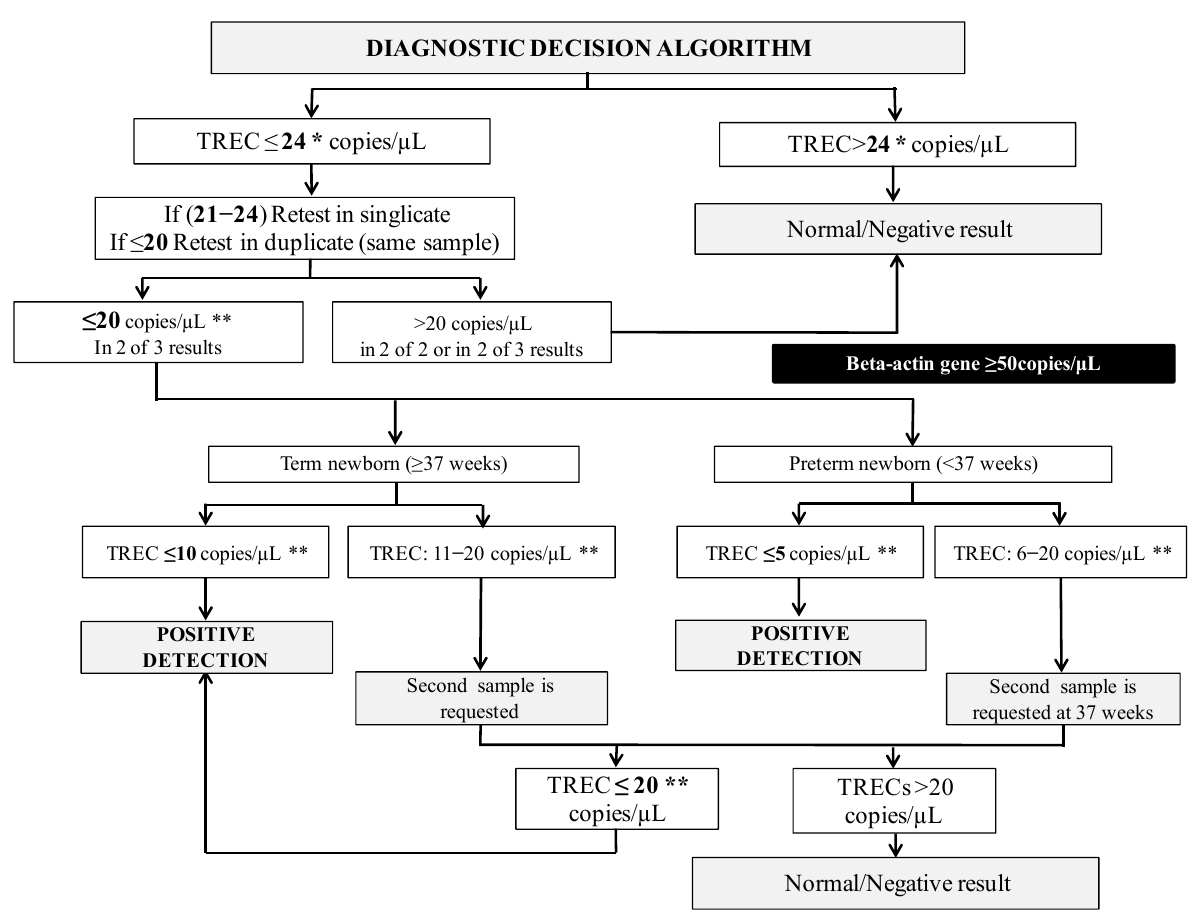
Figure 1. SCID NBS detection decision algorithm. * The retest cutoff was changed from 34 to 24 copies/ µ L in 2018. ** If the beta-actin gene < 50 copies/ µ L, a second sample is requested because the sample was considered of unsatisfactory quality. Abbreviations: TREC: T-cell receptor excision